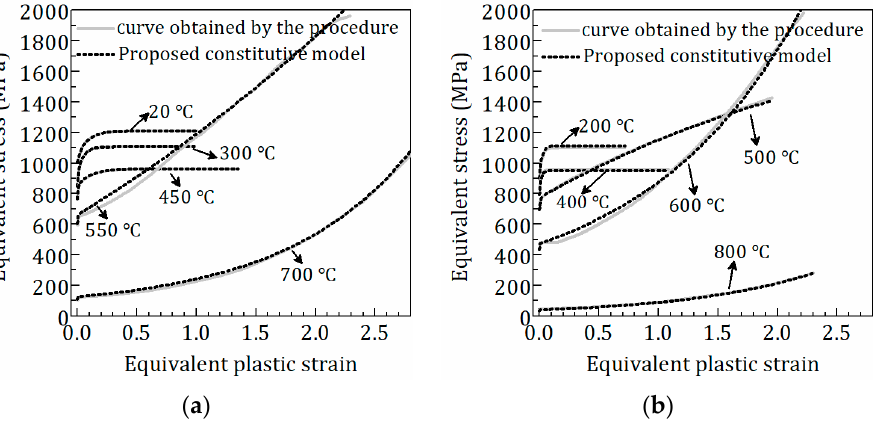
Figure 7. Comparison of the proposed constitutive model and equivalent stress-plastic strain curves: ( a ) 20, 300, 450, 550, and 700 °C; ( b ) 200, 400, 500, 600, and 800 °C. Table 3. Equivalent plastic strain at fracture of Q890 steel at elevated